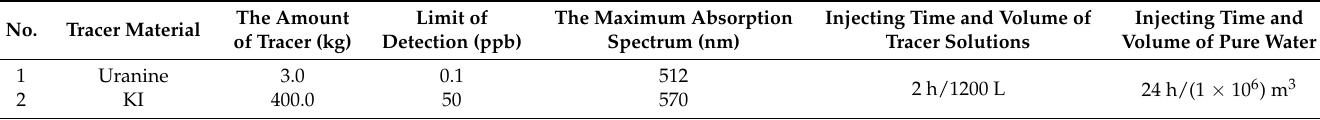
Table 2. Characterizations of two tracers used in this